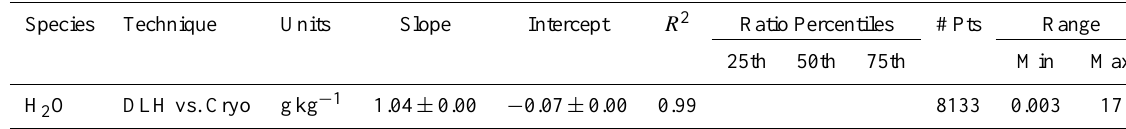
Table 4a. DC-8 intra-platform comparison. Photochemical precursors. NOTE: Technique is listed as X vs. Y.